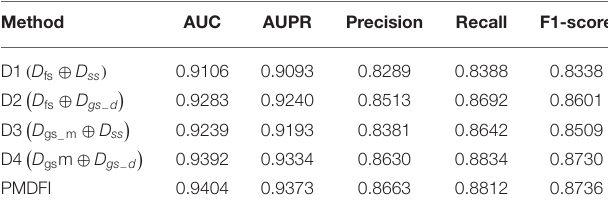
TABLE 3 | Comparison of the performance of four interactive cross